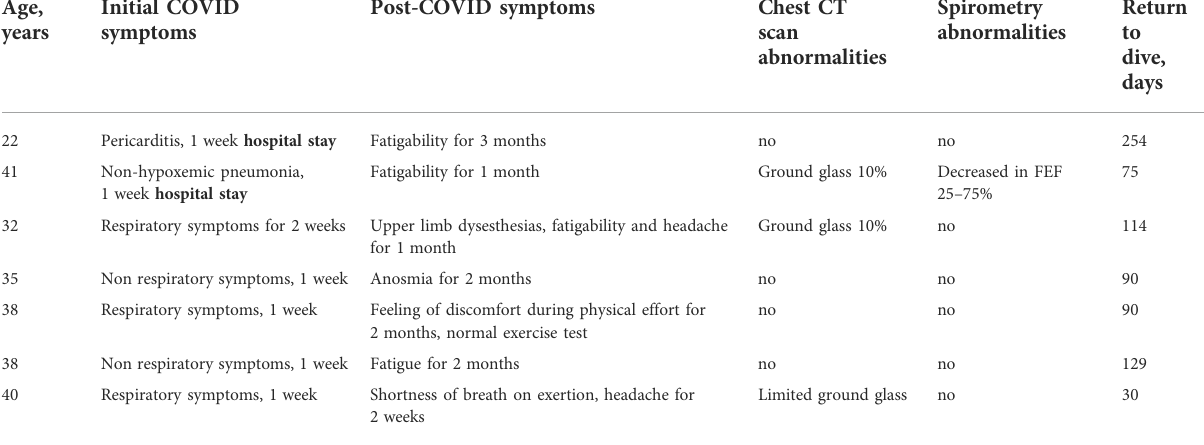
TABLE 2 Description of the 7 cases of divers with persistent subjective